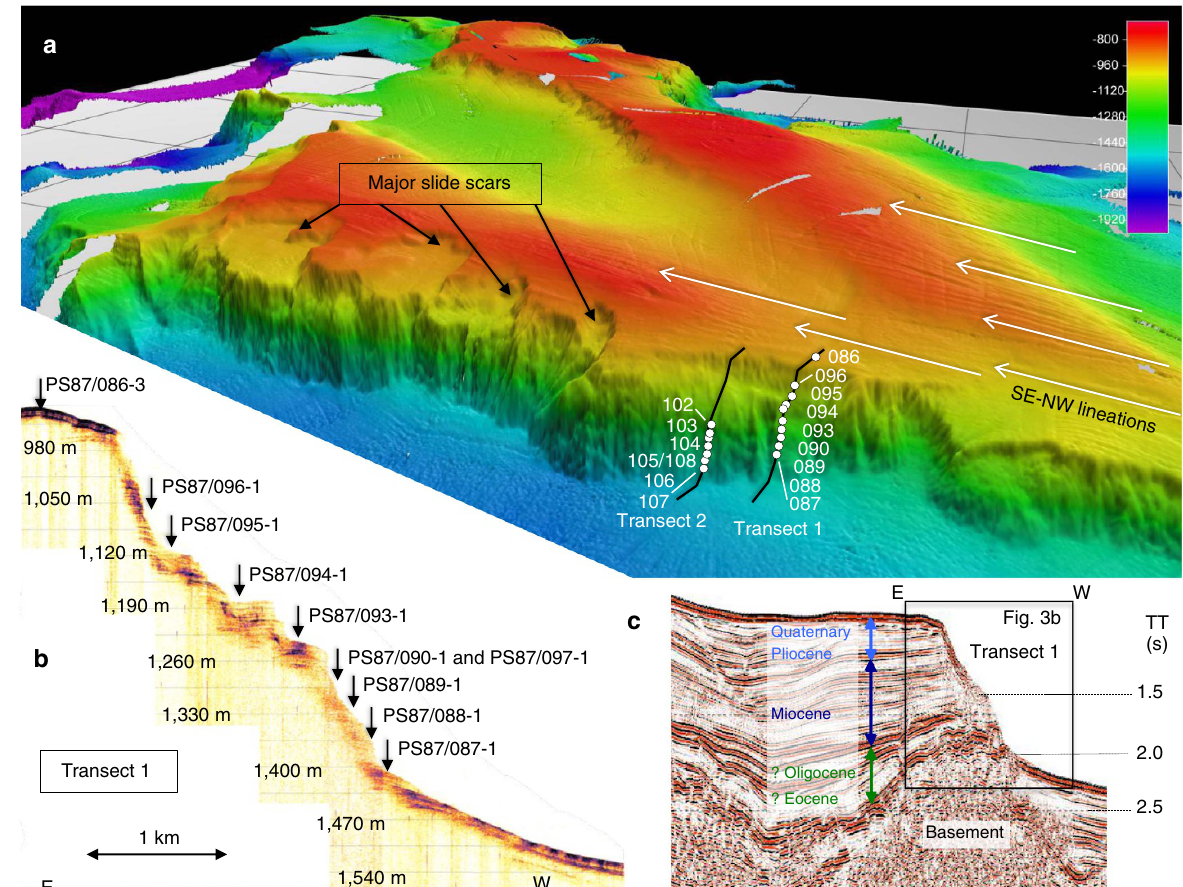
Figure 3 | Bathymetric and acoustic/seismic profiling records from southern Lomonosov Ridge. ( a ) Three-dimensional (3D) image of the swath bathymetry of southern Lomonosov Ridge, showing major slide scars and escarpments, streamlined SE–NW oriented glacial lineations formed beneath grounded ice sheets/streams and transects 1 and 2 with locations of sediment cores ( cf ., Supplementary Table 1). ( b ) PARASOUND profile across Transect 1 with locations of coring stations. ( c ) Processed multi-channel seismic profile AWI-20140311 across Transect 1, showing prominent reflectors and age assigments based on correlation between regional seismic lines and well data 22,23